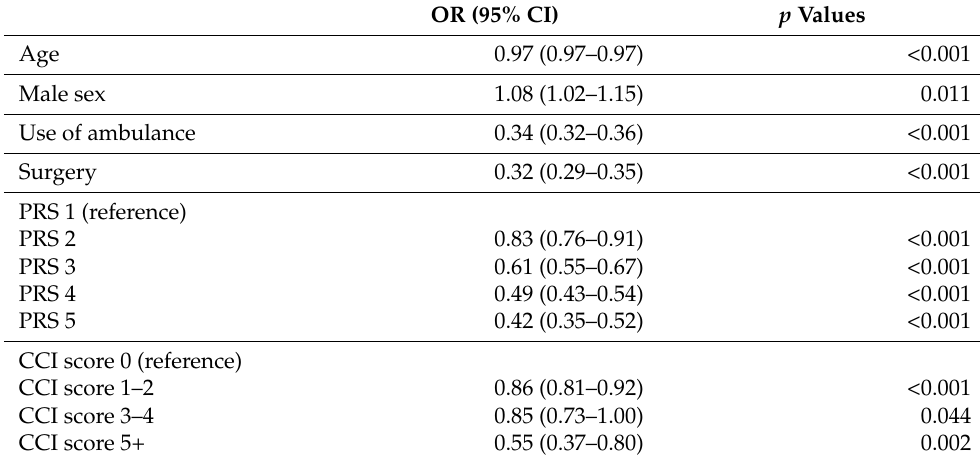
Table 3. Variables in the logistic regression analysis in five-year HSHR model.